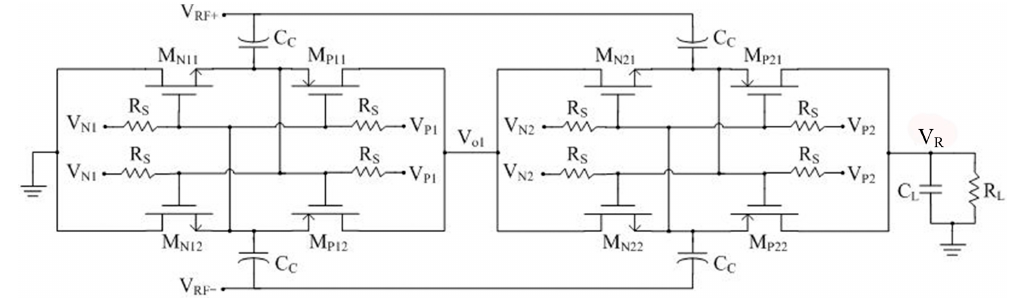
Figure 7. Schematic of the proposed rectifier.